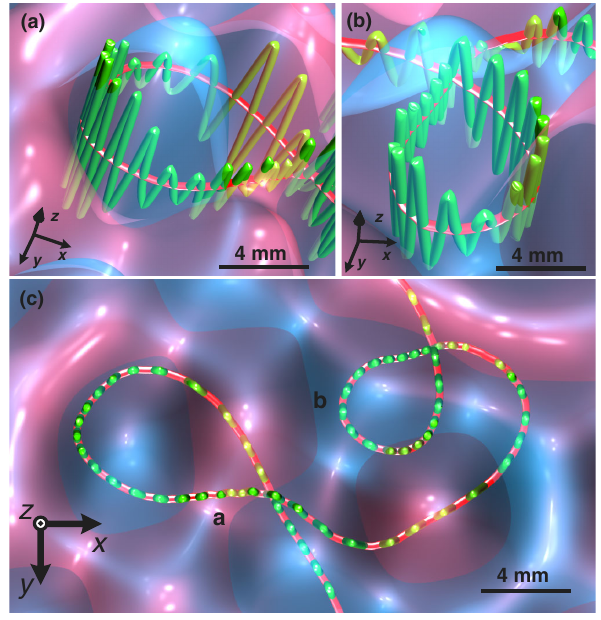
FIG. 4. Three-dimensional loops along one particle trajectory in FWatlowdrive a ¼ 1 g and f 0 ¼ 60 Hz( ϵ ¼ 0 . 67 ).Thecoordinate system indicates the different viewpoints with z indicating the ascending vertical. The green line is the three-dimensional trajec- tory, the red line corresponds to the horizontal projection of this trajectory. Pink and blue wave fields correspond to two consecutive phase extrema of the waves that are thus separated in time by one period of the shaker oscillation (Faraday waves are parametrically excited waves). (a),(b) Close-up (perspective views) on almost perfectlycircularloopsalongthetrajectory,thoseloopshavearadius close to ≈ λ = 2 . (c) Top view (orthogonal projection) on a portion of this trajectory that corresponds to a 2 s interval. Theview is zoomed out to show the two complete loops displayed in (a) and (b).